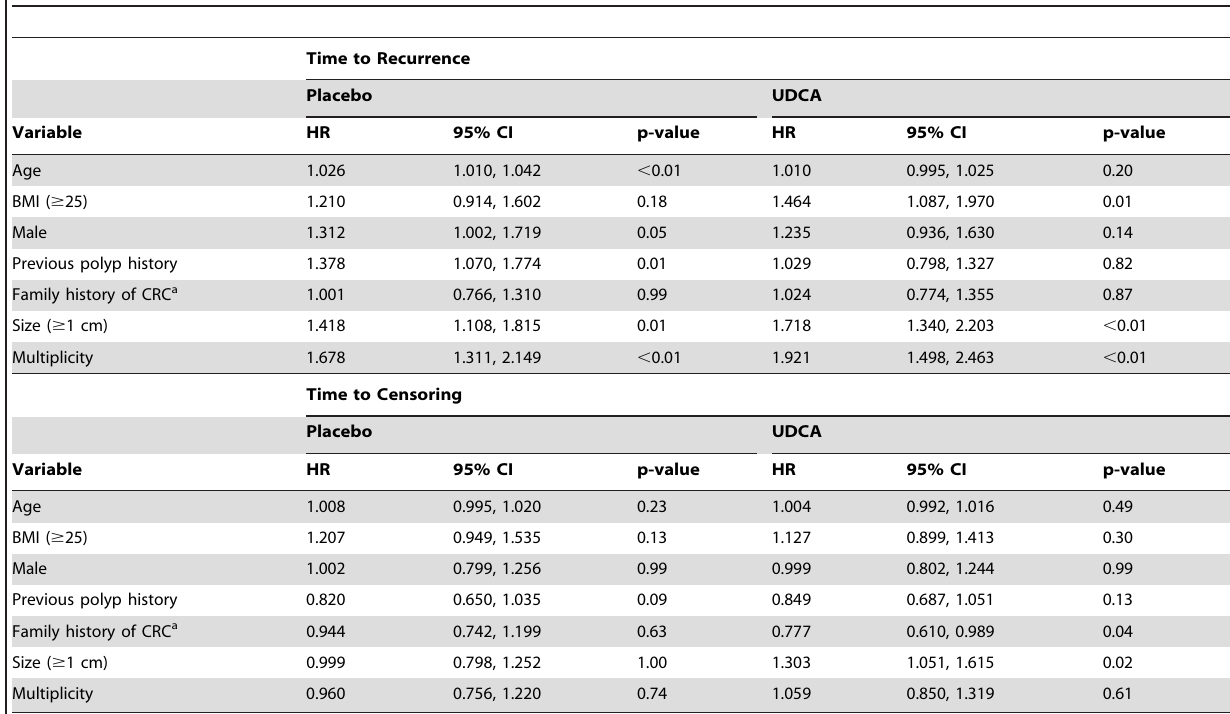
Table 1. UDCA Study: Univariate analysis based on a PH